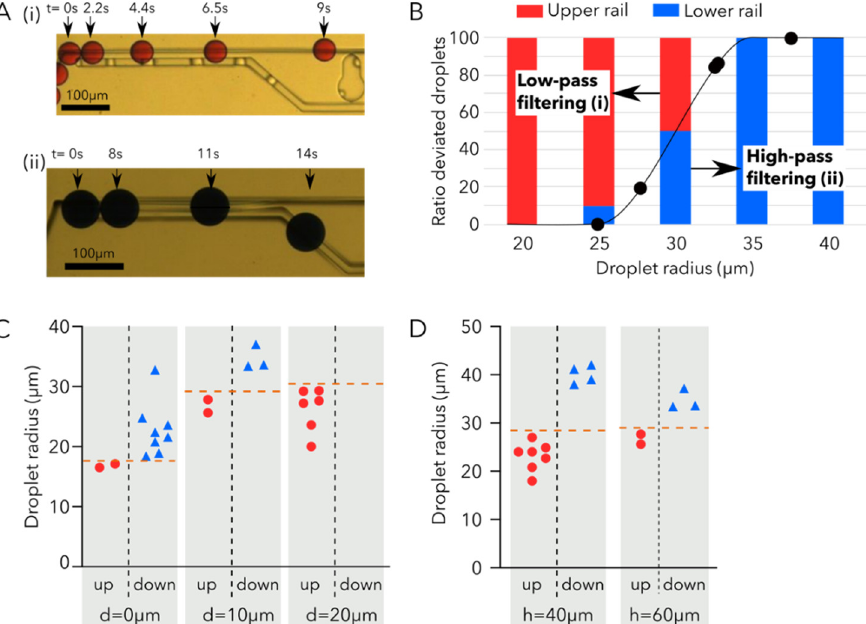
Figure 3. Droplet rail filtering system. ( A ) ( i ) Time-lapse of a small droplet continuing on the narrow rail. ( ii ) Time-lapse of a big droplet being deviated to the wider rail ( B ) Graph of the ratio of deviated droplets as a function of the droplet radius for the experimental case presented in ( A ). The droplets either remain on the narrow rail (low-pass filtering) or are deviated to the wider rail (high pass filtering) according to their size. ( C ) Number of droplets sorted according to the droplet radius for different gap distances between rails (called d). The droplet threshold transfer is indicated in orange. ( D ) Number of droplets sorted according to the droplet radius for different rail heights. The droplet threshold transfer is indicated in orange. Videos are available in Videos S1 and